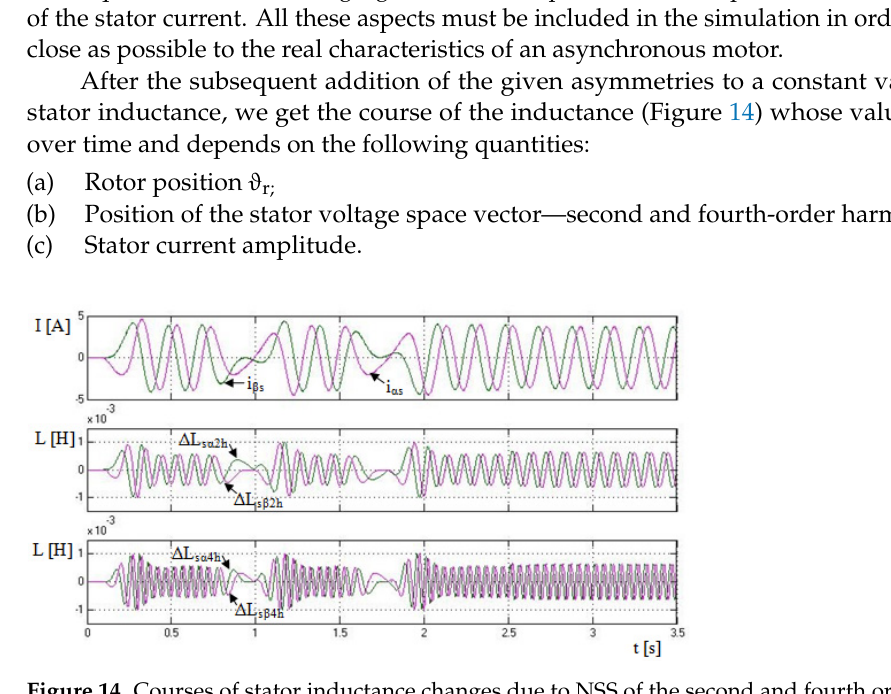
Figure 14. Courses of stator inductance changes due to NSS of the second and fourth order.